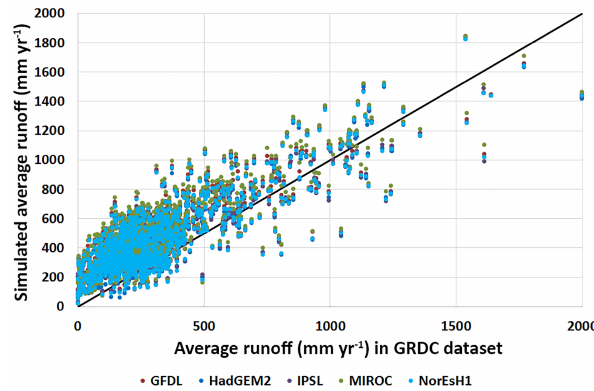
Figure 2. Comparison of GRDC average runoff with simulated average runoff in subbasins according to PCR-GLOBWB model forced in the control period (1960–1999) with the five climate mod- els.